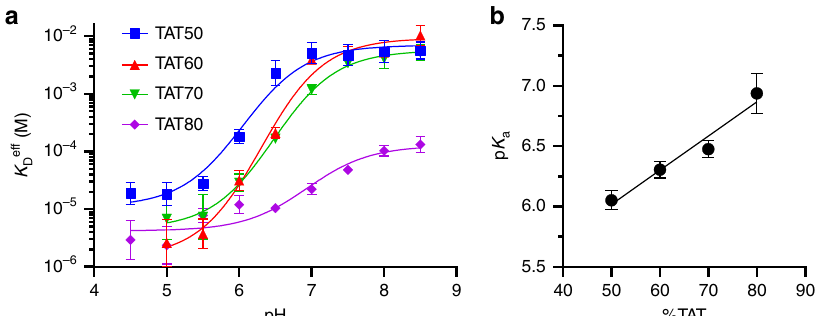
Fig. 2 pH response tuning through triplex base composition. a Constructs with varying TAT triplet compositions produce a range of pH dependencies, achieving selective binding at low pH but with varying magnitude of response and pH transition midpoint ( pK a ). b Increasing the TAT content of the triplex motif predictably shifts the pK a of the switch toward more neutral pH. Data points and error bars in a and b show the best fi t values and standard deviations extracted from fi ts to binding curve data from n = 3 independent experiments (data given in Supplementary Fig. 4) using nonlinear least squares fi tting. Source data are provided as a Source Data fi